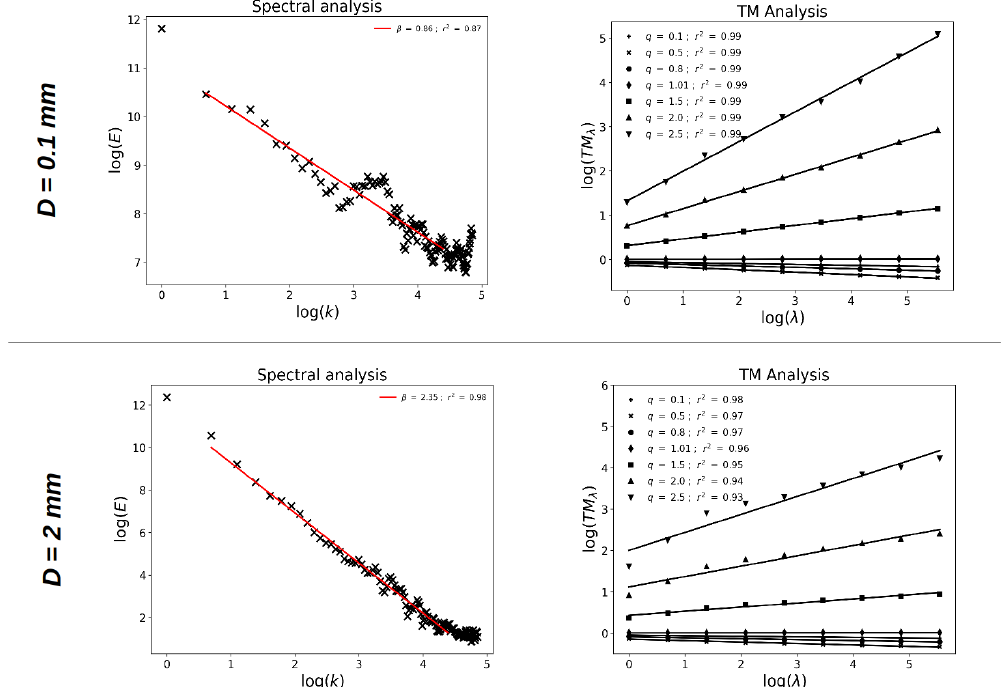
Figure 4. Scaling behaviour of the simulated drop velocity for D eq equal to 0.1mm (top row) and 2mm (bottom row). Spectral analysis (i.e. Eq. 8 in log–log) on the direct simulations is displayed in the left-hand column. TM analysis (i.e. Eq. 6 in log–log) on the velocity after implementing a fractional integration is displayed in the right-hand